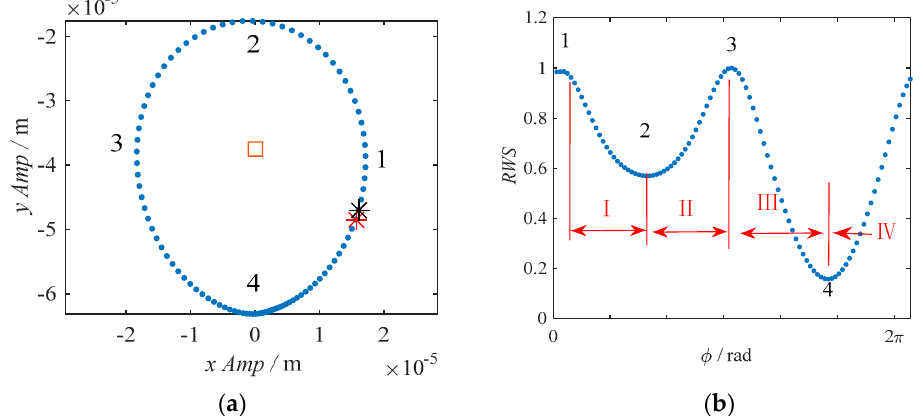
Figure 3. Steady state vibration response of normal system at µ = 0: ( a ) discrete axis orbit, ( b ) relative whirling speed.